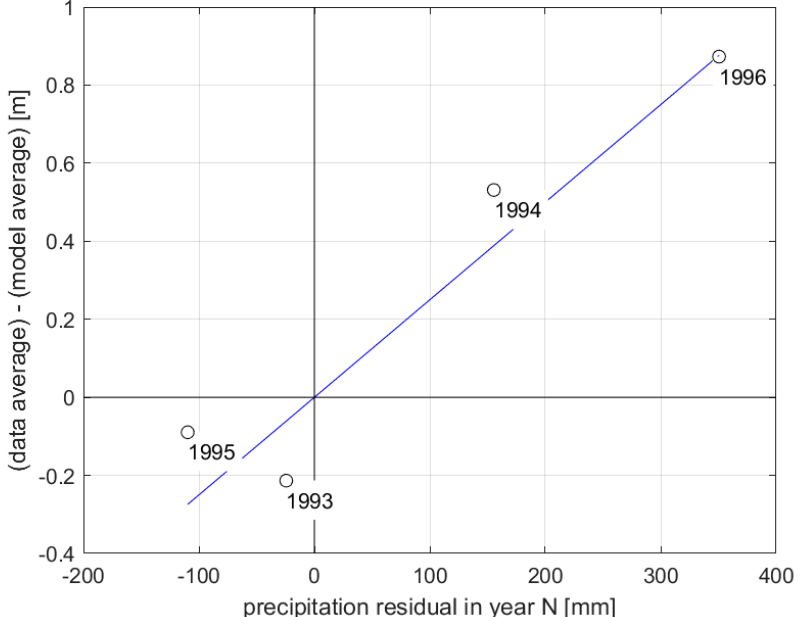
Figure 9. Proportionality between winter-averaged groundwater residual Δ and precipitation resid-